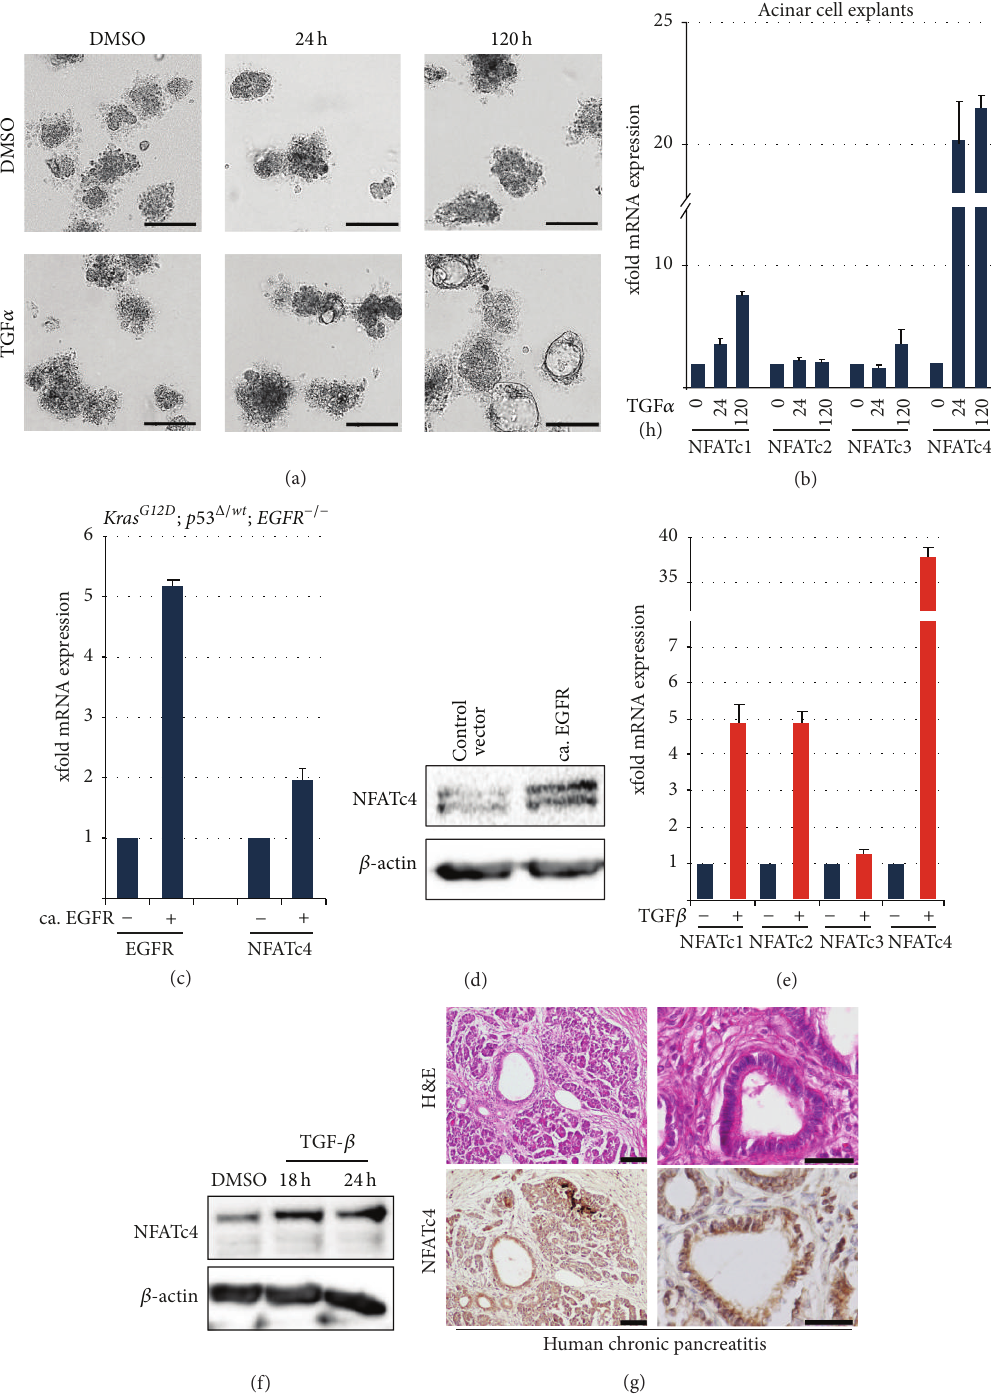
Figure 1: NFATc4 is induced in acinar cell transdifferentiation. (a) Light microscopy shows morphology of acinar cell extracts from wildtype mice in response to TGF 𝛼 for the indicated time points (scale bar represents 100 𝜇 m). (b) qRT-PCR to detect mRNA expression of NFAT isoforms in transdifferentiating acinar cells of wildtype mice in response to TGF 𝛼 . (c)-(d) NFATc4 mRNA (c) and protein (d) expression levels in Kras G12D ; 𝑝53 Δ/𝑤𝑡 ; EGFR −/− ; pdx1-Cre mice were determined after transient overexpression of a control vector or constitutive EGFR, respectively.NFATc4mRNAexpressionfollowingEGFRoverexpressionwasnormalizedtocontrol(means ± SD).(e)qRT-PCRrevealsmRNA expression of NFAT isoforms in primary tumor cells from Kras G12D ; 𝑝53 Δ/𝑤𝑡 ; pdx1-Cre mice following TGF 𝛽 treatment for 24 hours. (f) Western Blot analysis in primary tumor cells from Kras G12D ; 𝑝53 Δ/𝑤𝑡 ; pdx1-Cre mice upon TGF 𝛽 treatment. 𝛽 -actin was utilized as a loading control. (g) Representative H&E staining and immunohistochemistry were performed in human chronic pancreatitis samples. Scale bar represents 100 𝜇 m. Asterisks indicate NFATc4 positive